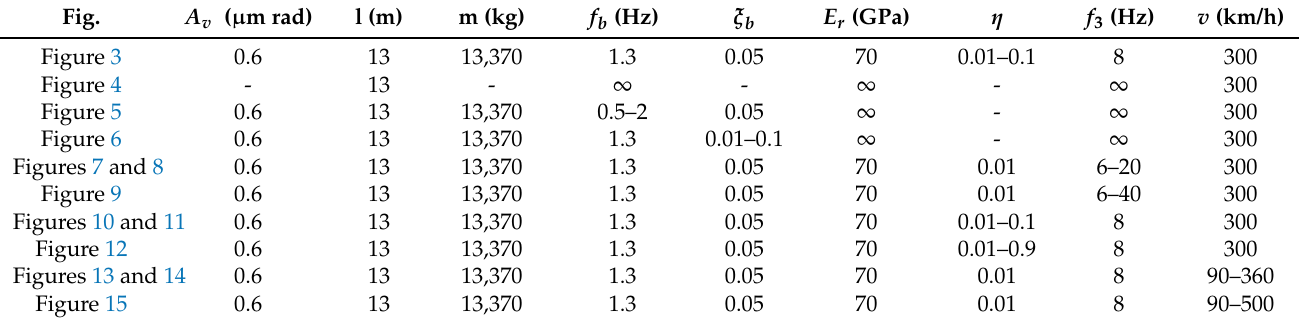
Table 1. Parameters used to obtain each of the